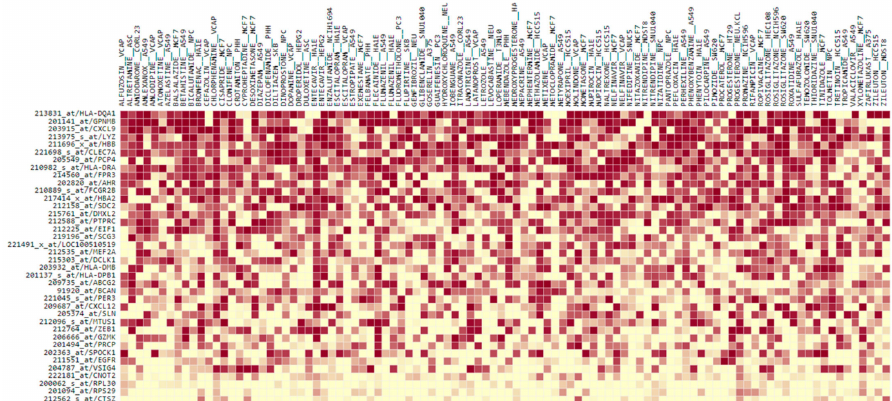
Figure 6. The normalized contribution fraction heatmap for the top 100 significant negative con- nections to target compounds identified for all cell lines identified by QUADrATiC software. Probes/genes have been sorted according to which DEGs in the signature are most affected by that drug. The DEG’s relative contribution is evident by their shading, which is on a scale from 1 (red) to − 1.0149